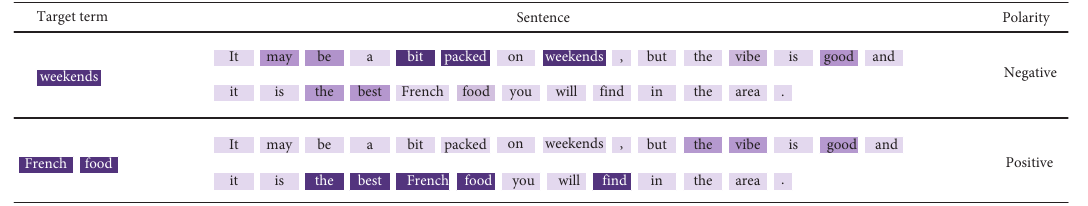
Figure 7: Visualized attention